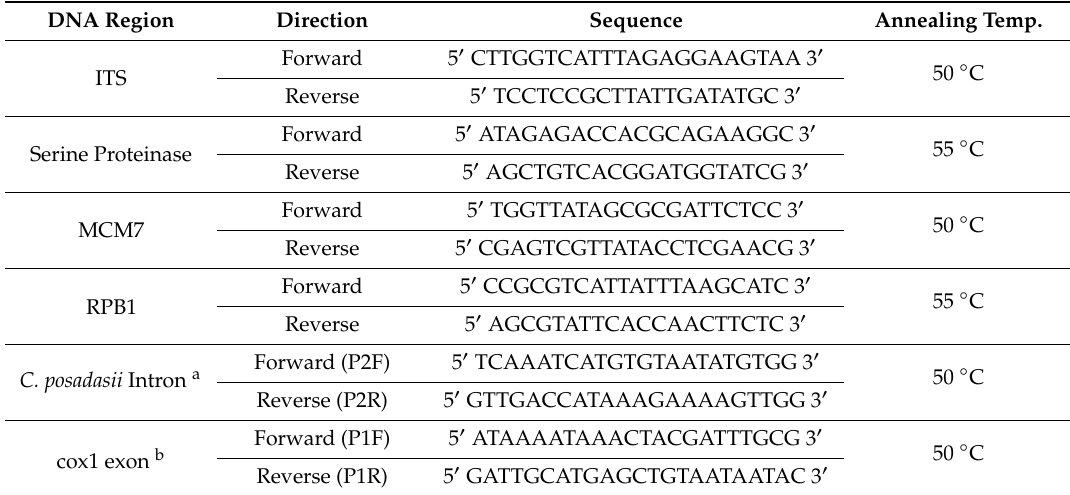
Table 2. Primers used in gene